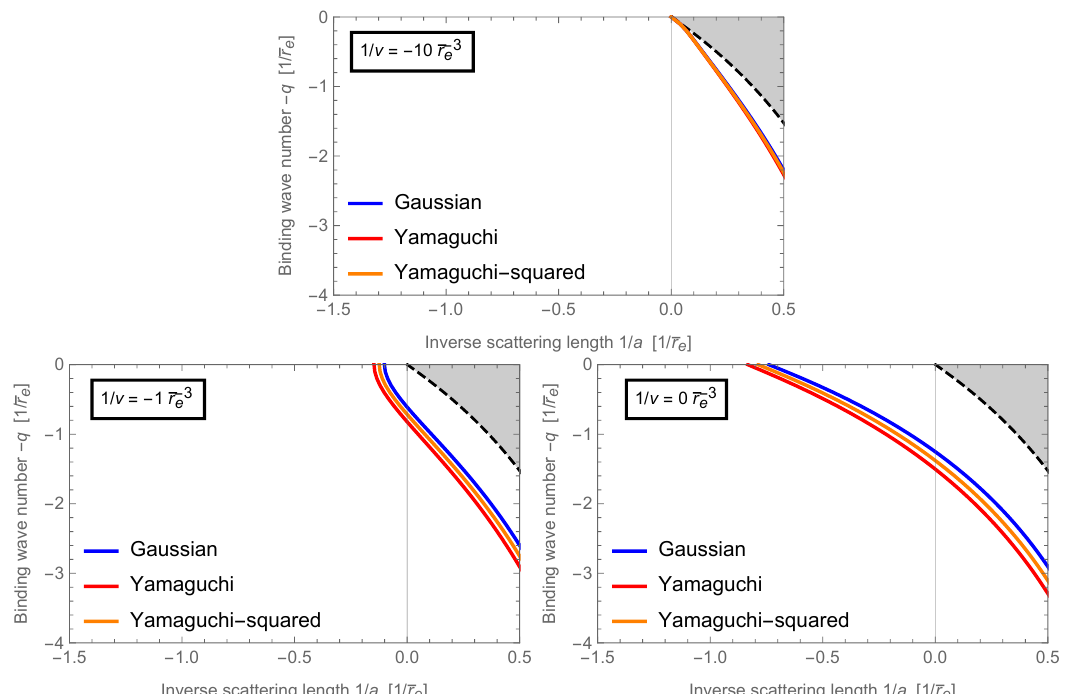
Figure 8: Dependence of the spectrum on the scattering volume v between fermions, for increasing values (in magnitude) of v , until a p-wave resonance is reached ( v = −∞ ). The plots are similar to the left panel of Fig. 2, although the different curves now correspond to different models of the p-wave interaction between the fermions. The value of the width parameter¯ α is fixed to 1 / ¯ r the scale of these plots, only the ground trimer is visible, the excited trimer being indistinguishable from the dimer (dashed